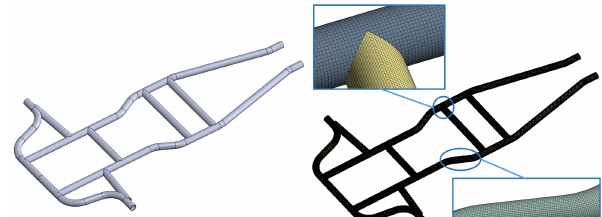
Figure 17. Schematic diagram of the frame model and finite ele- ment